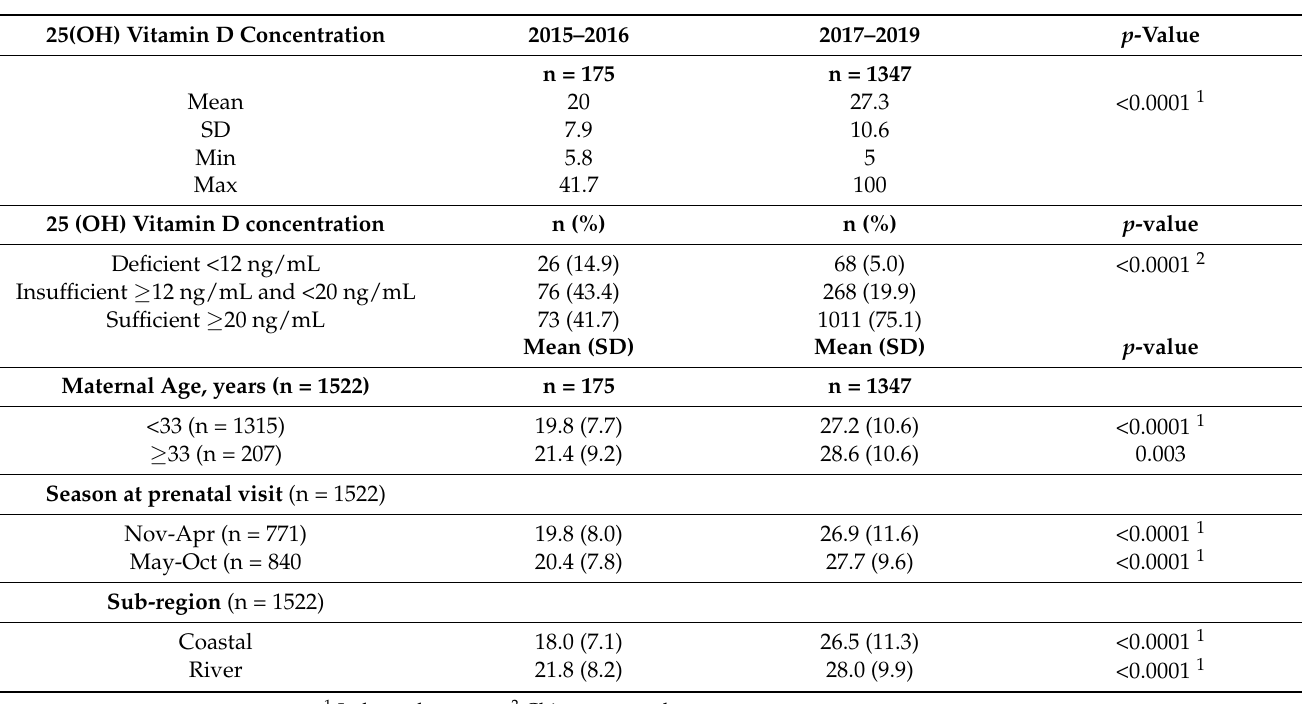
Table 3. Bivariate analysis of prenatal characteristics and 25-hydroxyvitamin D concentrations in late prenatal (20+ weeks gestation) Yukon Kuskokwim Delta women pre-supplementation (2015–2016) versus post-supplementation (2017–2019).